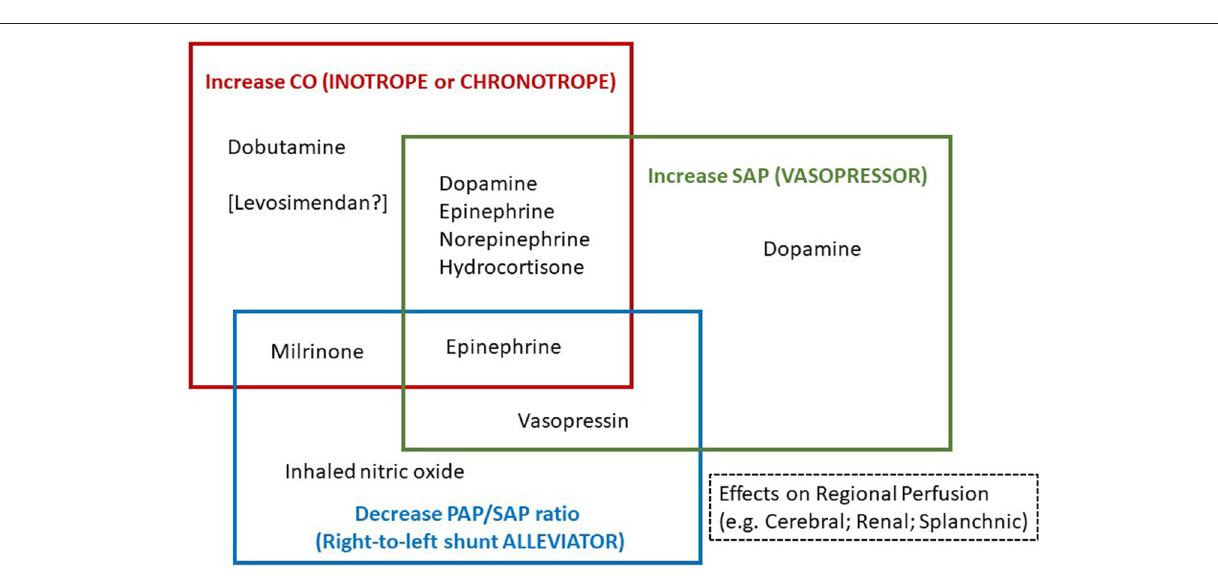
FIGURE 2 | Medications categorized according to three specific cardiovascular supportive functions; (a) to increase cardiac output (CO), (b) to increase systemic arterial pressure (SAP), or (c) to decrease pulmonary arterial pressure (PAP) to SAP